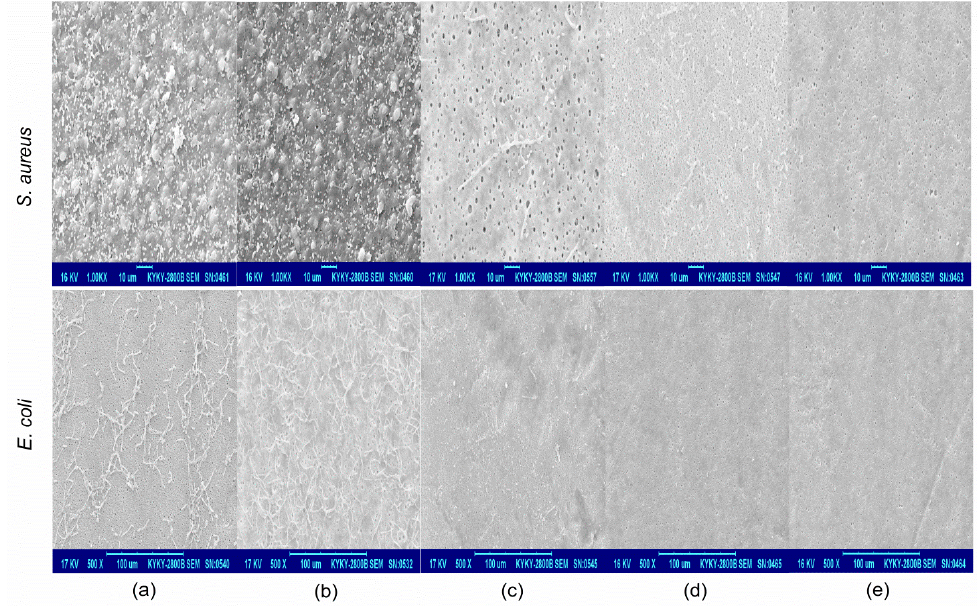
Figure 6. SEM images of bacteria adhesion and growth on ( a ) unmodified PES membrane; ( b ) PES-g-DMAEMA-BB; ( c ) PES-g-DMAEMA-OB; ( d ) PES-g-DMAEMA-DB; and ( e ) PES-g-DMAEMA-HB after the 24 h static adhesion experiment.